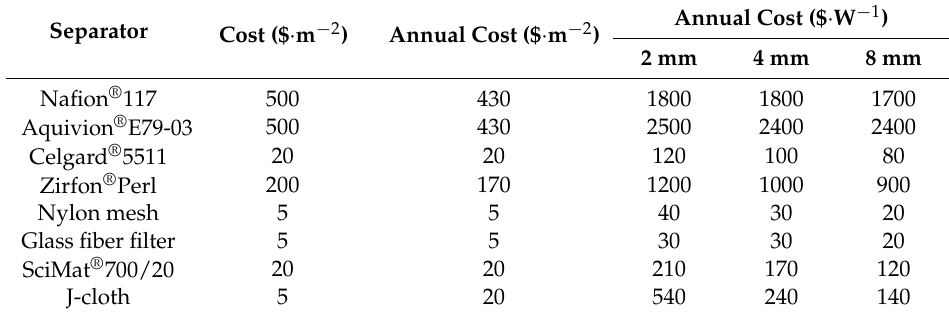
Table 4. Annual cost of the separator per watt of power output (estimated based on a lifetime of 1 year for J-cloth and 5 years for the other separators with an interest rate of 6% in a 25-year period).